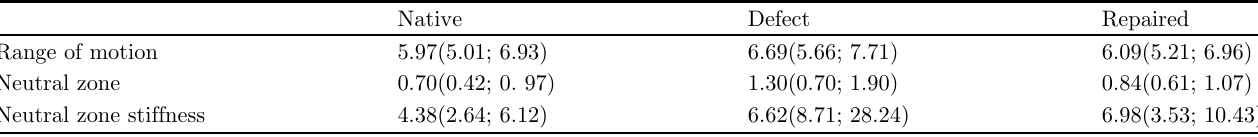
Table 1. Mean values with con fi dence intervals (cid:1) Flexion – extension.